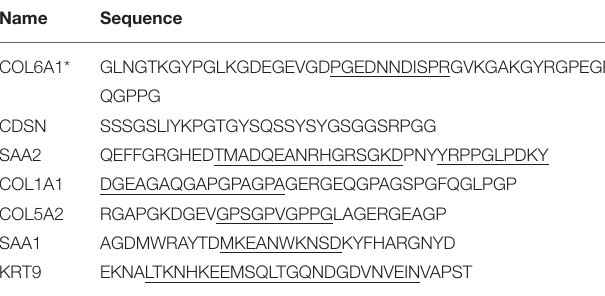
TABLE 2 | Homologous mouse peptide sequence used for screening self-reactive